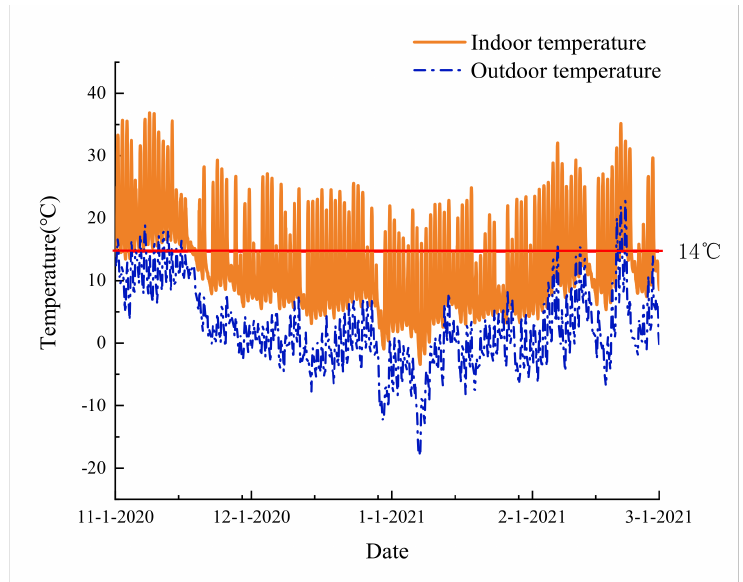
Figure 14. The simulated heating effect under the zero-state response control strategy in the winter of